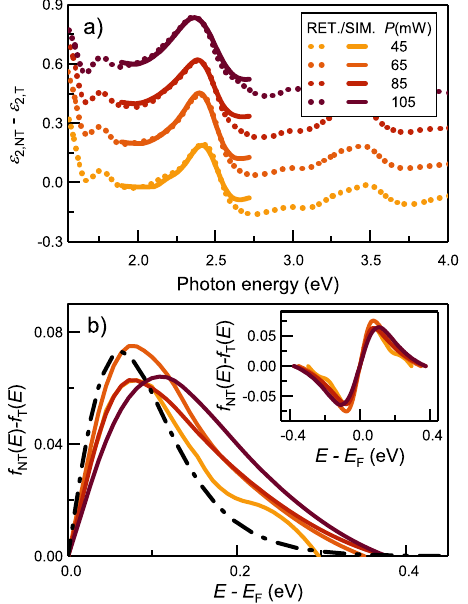
Fig. 4 | Differences in the dielectric function of the non-thermalized and ther- malized layers and thecorresponding differencesin theelectronoccupancies. a Retrieved (set of dotted curves) and simulated (set of solid curves) differences between the dielectric function of the non-thermalized top layer (NT) and the thermalized part (T) of the gold fi lm and ( b ) the corresponding changes in the electronoccupanciesaboveFermi-level.Theinsetshows Δ f(E) inthewholeaffected energy range. For comparison, the difference of two Fermi-Dirac distributions belonging to Δ T = 275K is presented with a dash-dotted